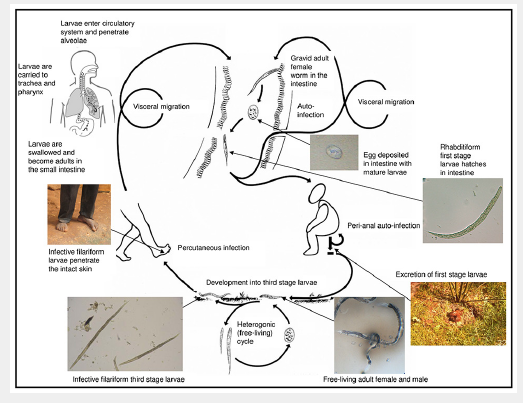
Life cycle of Strongyloides stercoralis . (Adapted from Olsen A, van Lieshout L, Marti H, Polderman T, Polman K, Steinmann P, et al. Strongyloidiasis – the most neglected of the neglected tropical diseases? Trans R Soc Trop Med Hyg. 2009;103:967–72 [85]. © Elsevier, 2009. Printed with